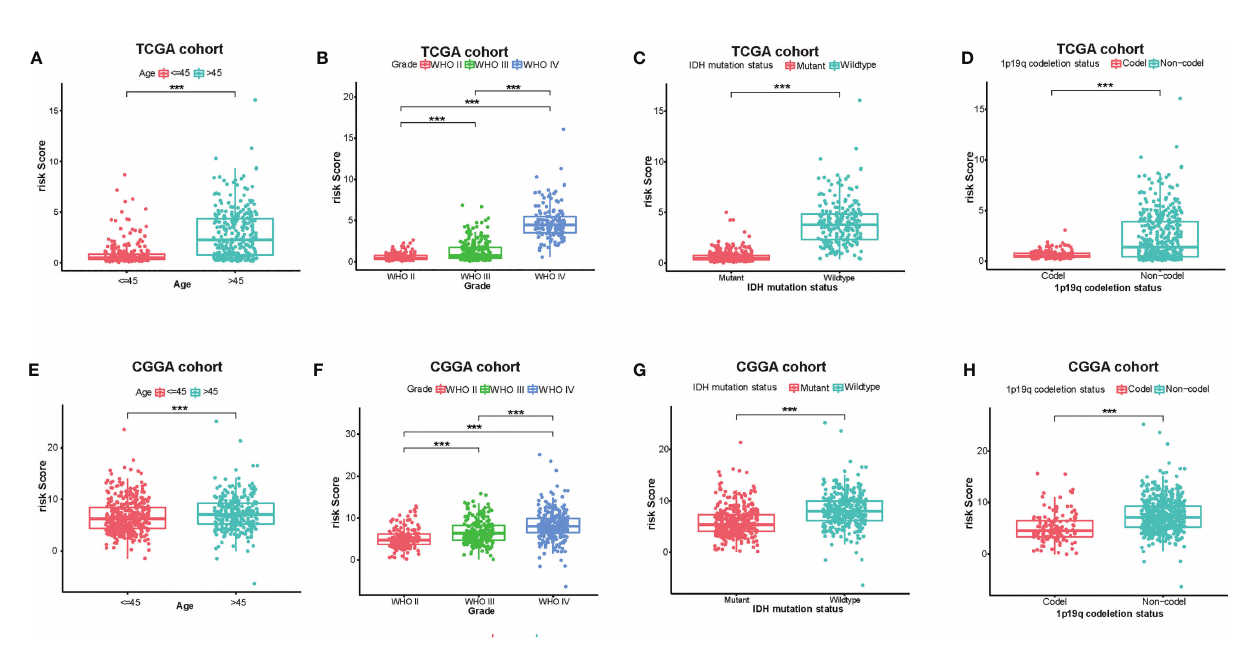
FIGURE 4 | Associations between the amino acid-related and immune-associated signature and other features in both the TCGA and CGGA datasets. Distribution of the amino acid-related and immune-associated gene signature in patients strati fi ed by age (A , E) , WHO grade (B , F) , IDH1 status in each grade (C , G) , and 1p/ 19q status (D , H) ; *** P < 0.001. IDH, isocitrate dehydrogenase; TCGA, The Cancer Genome Atlas; CGGA, Chinese Glioma Genome Atlas; Codel, codeletion; GBM, glioblastoma; WHO, World Health